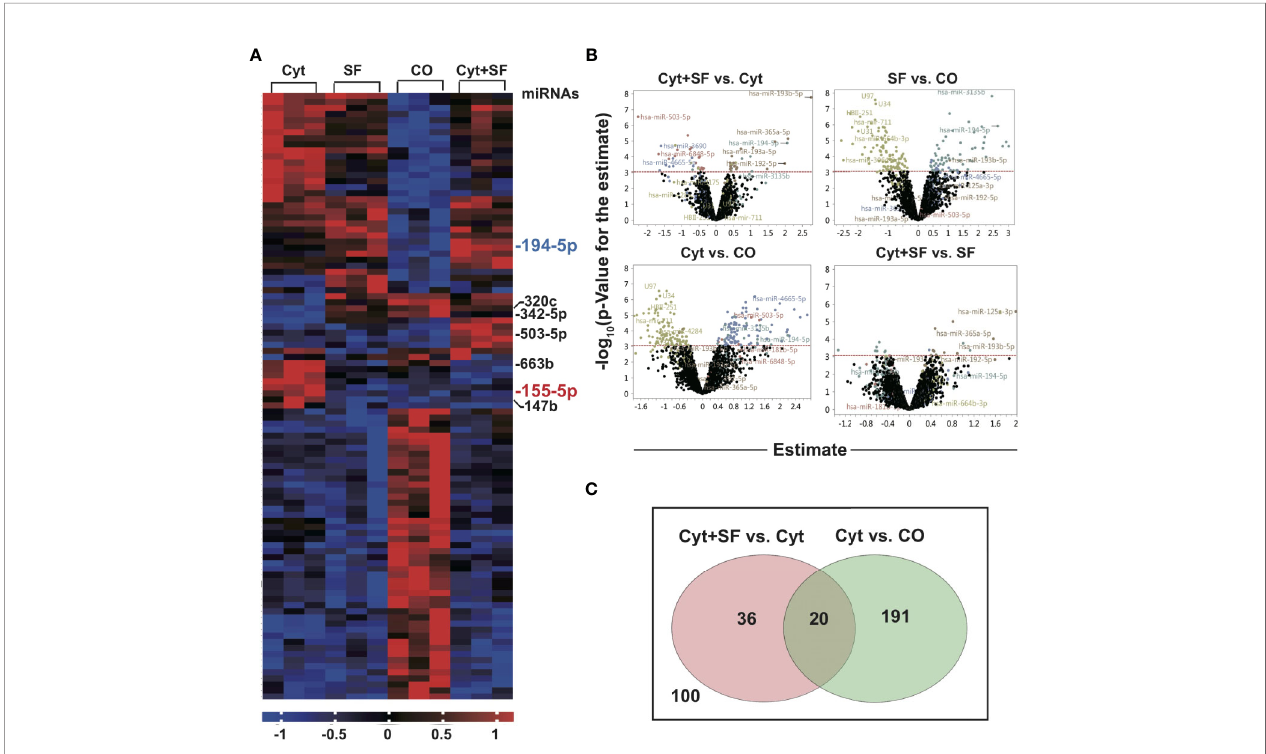
FIGURE 4 | Sulforaphane differentially regulates microRNAs (miRNAs) in dendritic cells (DCs). (A) Monocytes were isolated from peripheral blood mononuclear cells (PBMCs) using CD14 MicroBeads and monocyte-derived dendritic cells (MoDCs) were produced in vitro . MoDC were treated with 30 µM sulforaphane (SF) or vehicle control for 30 min, then cytokine cocktail (Cyt) or vehicle control were added into the cultures for 48 h followed by miRNA extraction. The miRNA array analysis and bioinformatic evaluation were performed to select the most signi fi cantly regulated miRNAs. The heat map presents most signi fi cantly differently expressed miRNAs across 4 groups. The red colors indicate high expression, and the blue colors indicate low expression within a scale from 1 to -1. (B) The four Volcano plots demonstrate the distribution of differentially regulated miRNAs in respective comparisons. On the y-axis, the – log10 p-Value (the grade of signi fi cance) is plotted; on the x-axis, the estimate for the comparison (fold change) is represented. (C) Venn diagram shows differently regulated miRNAs candidates between the groups (Cyt+SF) and (Cyt) as well as between the groups (Cyt) and (CO). The overlapping 20 miRNAs are the promising candidates for the observed sulforaphane effect on